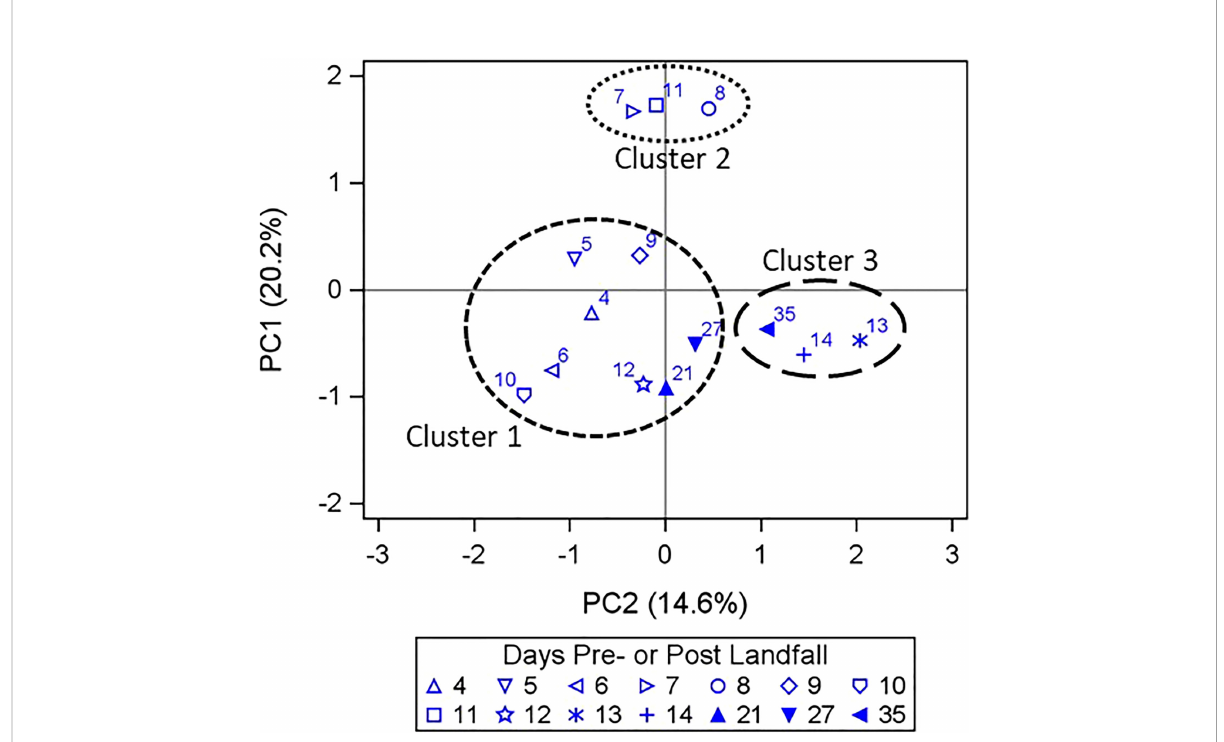
FIGURE 8 Principal components analysis for post-landfall surface water. Cluster analysis results are shown and include surface water samples labeled by days since the initial landfall. The * symbol is de fi ned in the legend with all other symbols. * is station